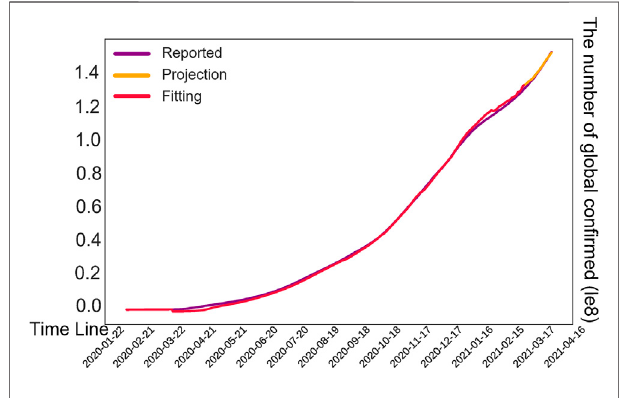
FIGURE 8 | Prediction results of our model. The vertical axis represents the number of global con fi rmed cases. The red lines are fi tted trends, the purple lines are actual cases, and the orange lines are predicted trends over the next month.